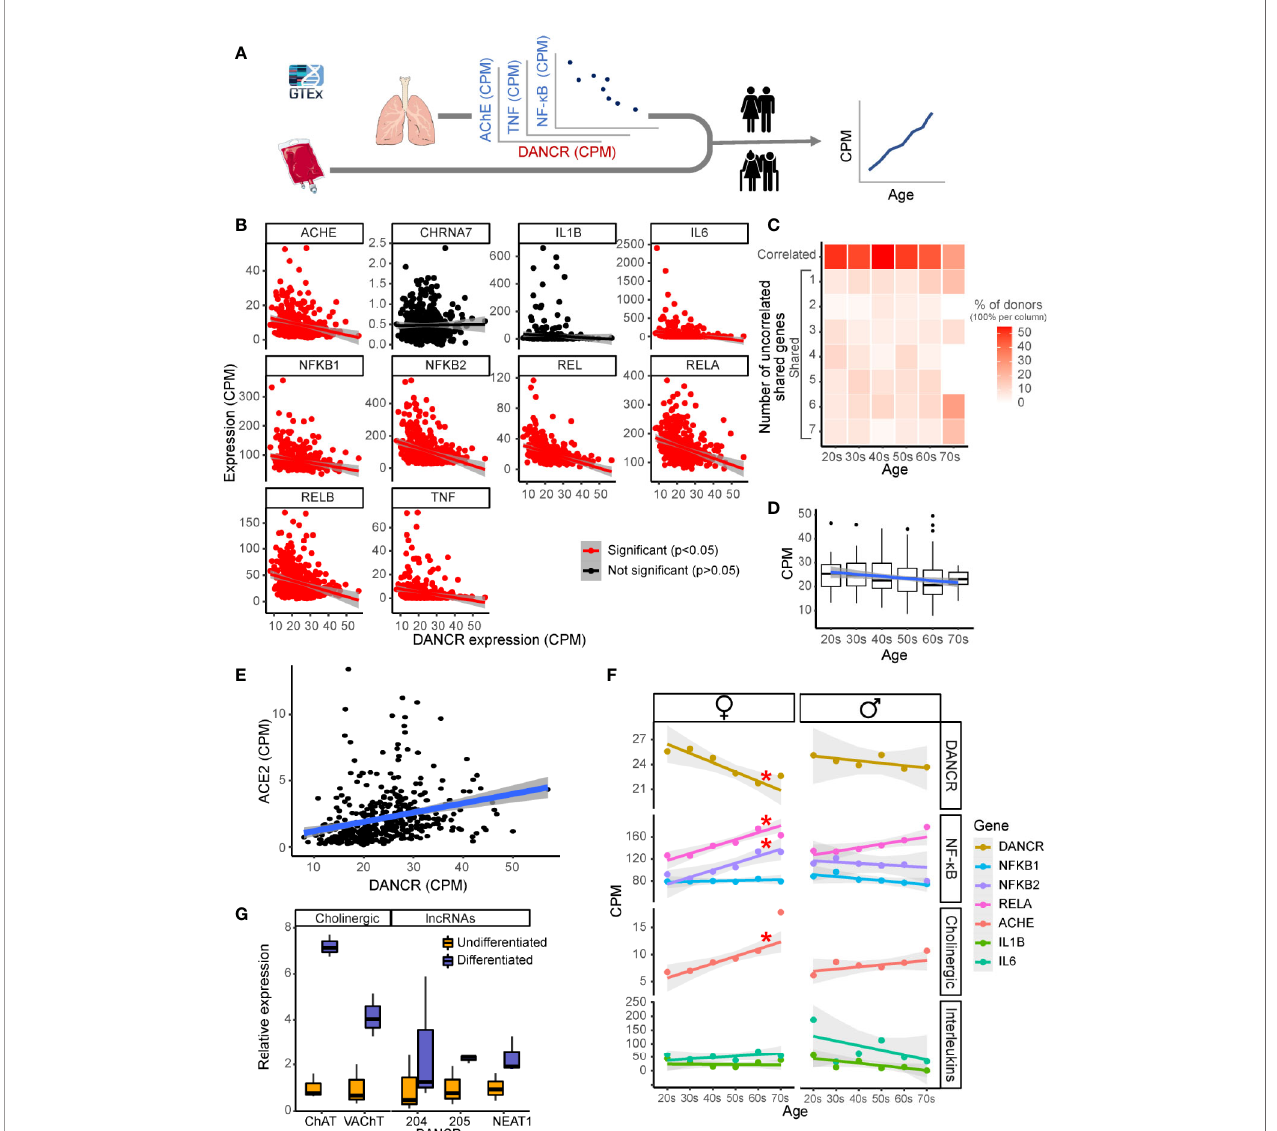
FIGURE 3 | DANCR shows inter-related age- and sex-associated correlation with elevated lung in fl ammatory genes and associates with ACE2. (A) Expression of DANCR and other genes in 419 lung samples was followed post-mortem in healthy GTex individuals. Correlation between coding genes to DANCR expression was tested in lungs and age correlation — in lung and blood. (B) Signi fi cant (red, p < 0.05, FDR) and insigni fi cant (black) correlation of DANCR to cholinergic- and in fl ammation-related genes in lung samples. (C) Heat-map showing age-related decline in DANCR ’ s correlation with the red-colored genes in B. The samples were sorted by the number of genes whose links were signi fi cant in the different age groups. Color scale shows calculated relative share of each subgroup of the total population at this age. A trend (R = 0.7, p < 0.1) was seen for the correlation of age with the fraction of donors whose values appeared signi fi cant. (D) Expression of DANCR in lung samples along age (R = -1.3, p < 0.008). Boxplots in grey show expression variability in each age group. (E) Correlated expression of ACE2 and DANCR in 419 lung samples from the GTEx dataset (R = 0.25, p < 0.0001, Pearson). (F) Correlation of various transcript levels with age in 427 lung samples. Red asterisks indicate signi fi cance of p < 0.05 (FDR). (G) Neuroblastoma cells of female (LA-N-2) and male (LA-N-5) origin were treated with CNTF to induce cholinergic differentiation, or PBS-treated for control cells. Four days post-treatment, the levels of lung transcripts were qPCR measured and normalized to GAPDH levels (n=3 biological replicates for each qPCR condition). ChAT and VAChT were upregulated in differentiated cholinergic neurons (p < 0.01, p < 0.05), the neuroprotective long variant of NEAT1 (p < 0.09) and two common transcripts of DANCR, DANCR-204 (709 bp) and DANCR-205 (748 bp) (p < 0.43, p < 0.063,